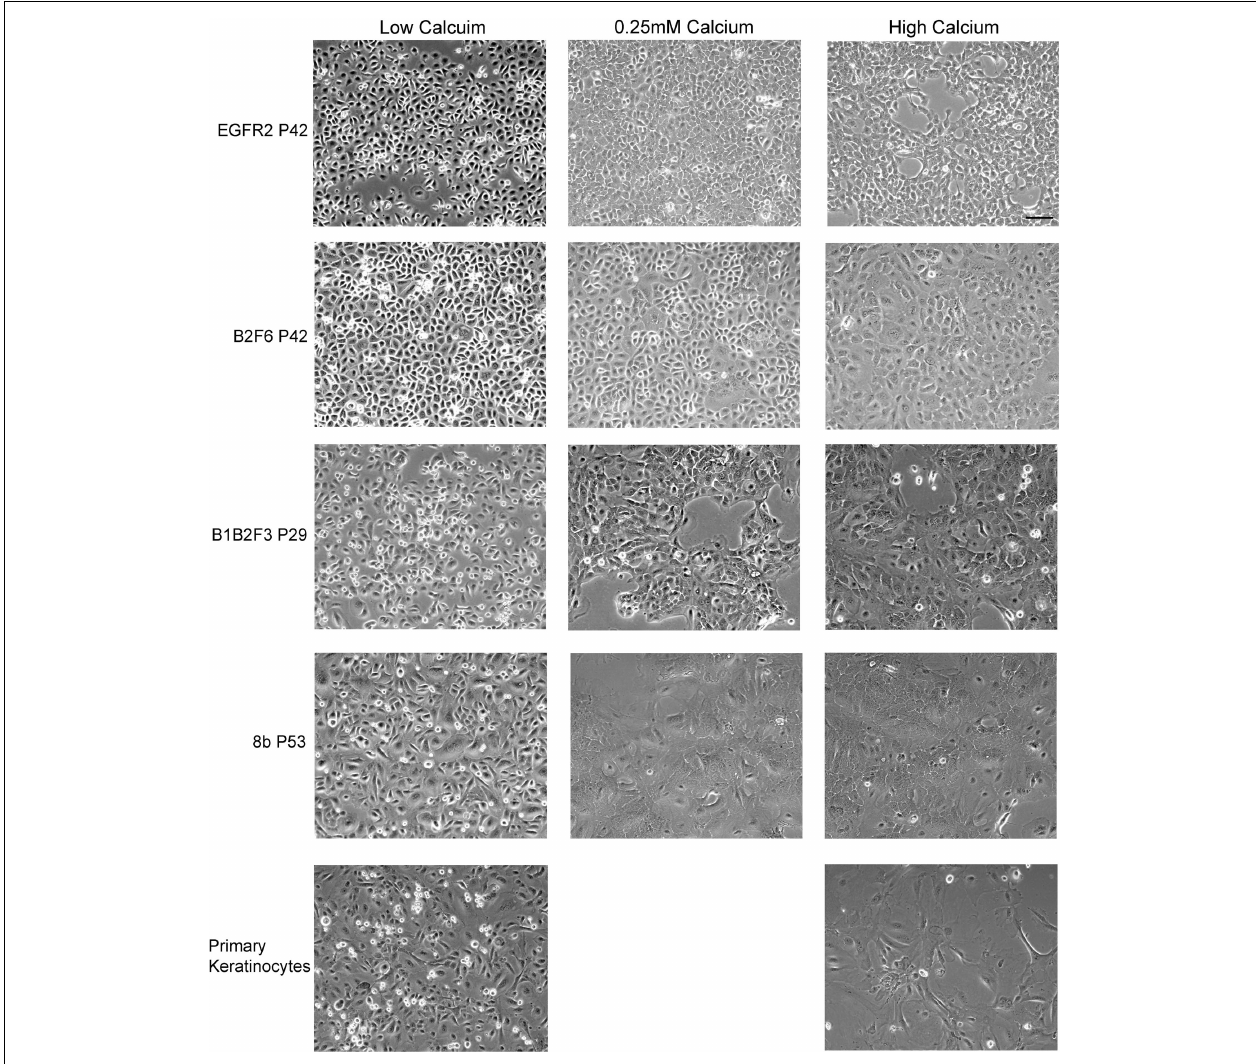
FIGURE 2 | Immortalized cells maintain morphologic characteristics of primary keratinocytes . Immortalized EGFR2 cells generated from an Egfr fl/fl mouse on an FVB/N background, immortalized B2F6 cells generated from an Erbb2 fl/fl mouse on an FVB/N background, immortalized B1B2F3 cells generated from an Egfr fl/fl /Erbb2 fl/fl mouse on an FVB/N background,